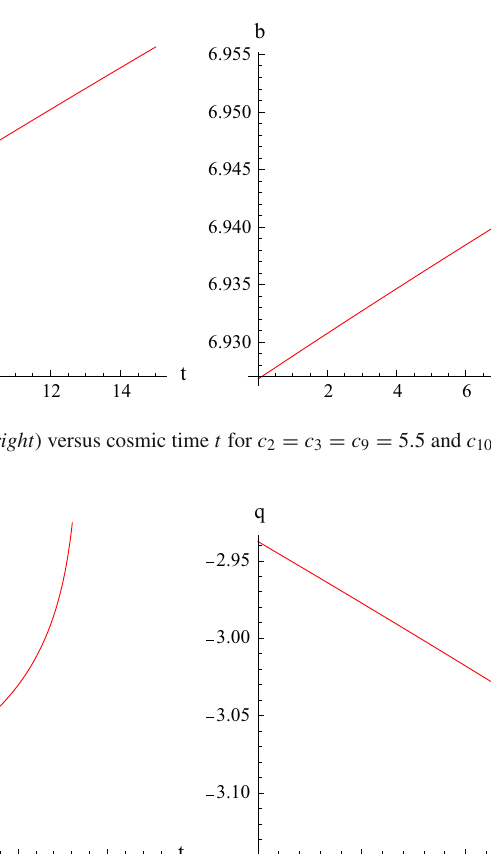
) cos 4 ( c c 2 2 3